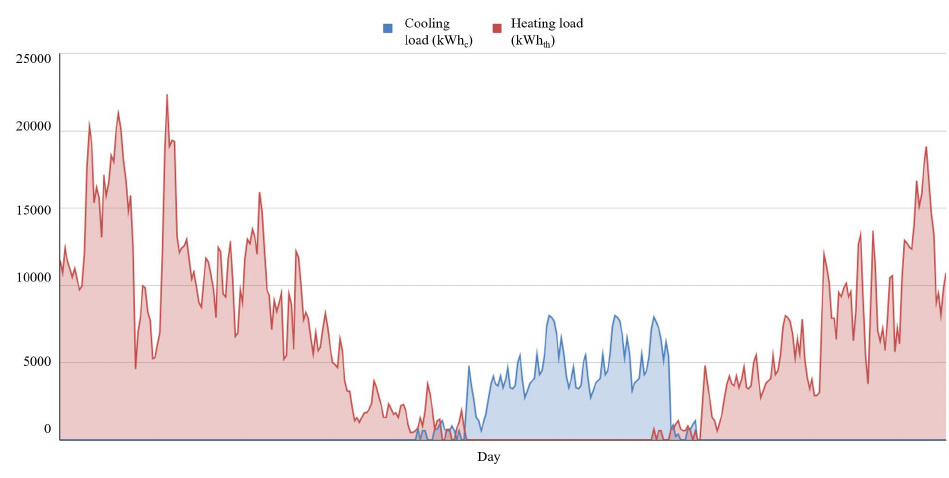
Figure 6. Yearly fluctuation of heating and cooling load for the case of Kimmeria, Xanthi, as proposed in [16].